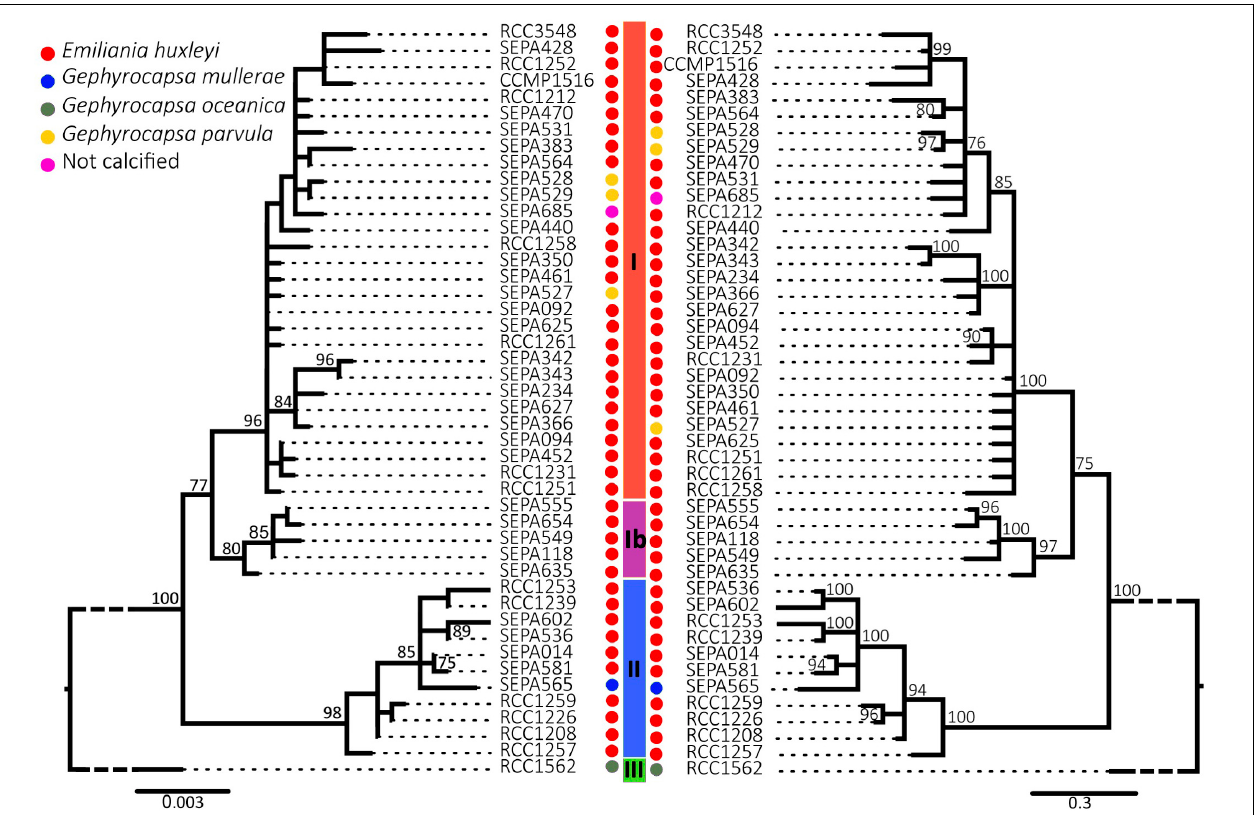
FIGURE 2 | Phylogenetic tree of constructed from concatenated cox1–cox3 alignment. At nodes are shown bootstrap (Maximum Likelihood, left tree) or posterior probability support (Bayesian Inference, right tree) values above 75%.